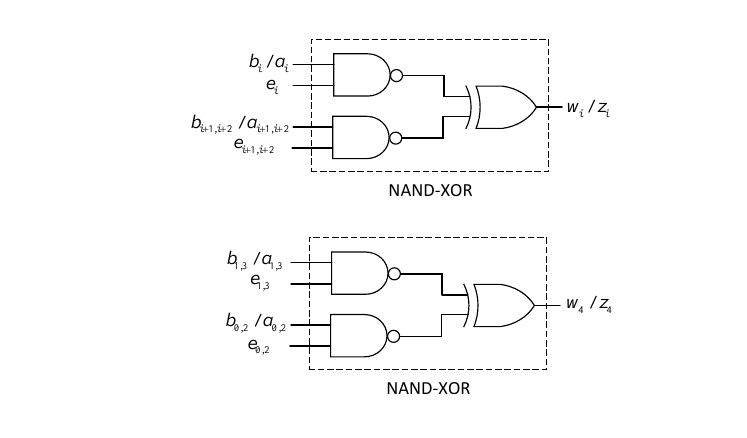
Figure 5: The proposed output multipliers over GF (2 4 ) to generate w i /z i , 0 ≤ i ≤ 3 , and w 4 /z 4 . Note that the additions in the input indices are performed modulo 4.